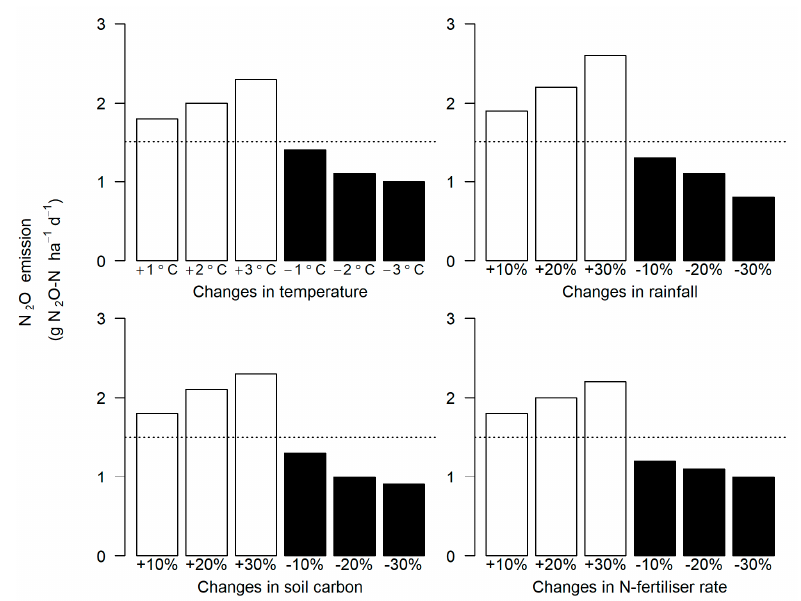
Figure 5. Sensitivity of the DNDC-model to changes in climate (temperature and rainfall), soil characteristics (soil carbon) and management practice (nitrogen fertiliser rate) on N 2 O emissions. Dotted line represents the baseline threshold (annual average maximum temperature = 12.8 ◦ C, average daily precipitation = 4 mm, soil carbon = 0.0038 kg C kg − 1 soil and N-fertiliser rate applied = 100 kg N ha − 1 ).